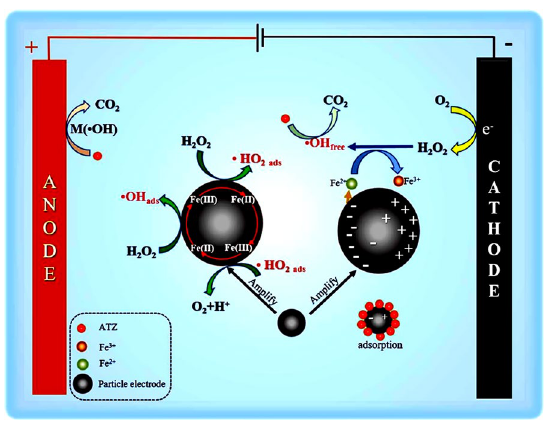
3 H (Dash et al. 2018)